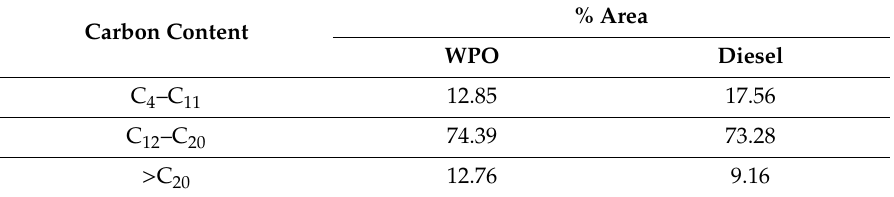
Table 4. Components identified from waste plastic oil and diesel by GC–MS